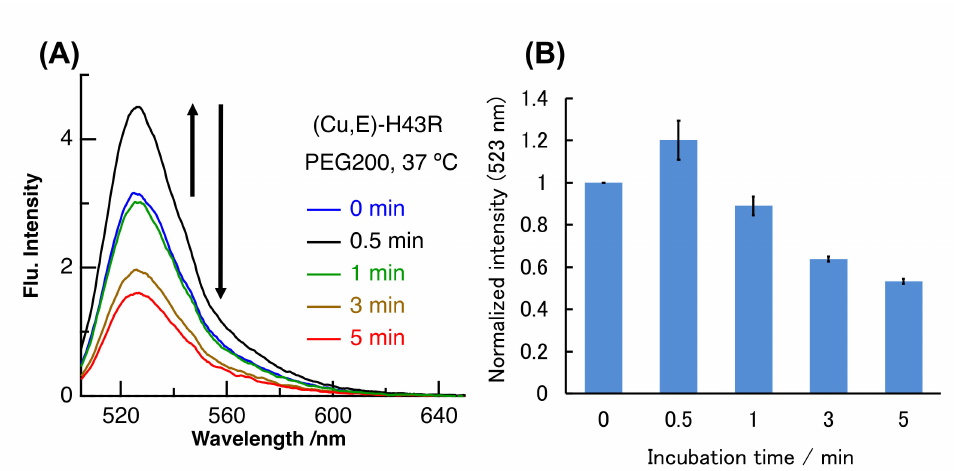
Figure 5. ( A ) Pro-oxidant activities of (Cu,E)-H43R at 37 ◦ C after di ff erent incubation times in 20 wt% PEG200 solution. ( B ) DCF intensities normalized by the value at 0 min for ( A ). Error bars are SE ( n = 3). Pro-oxidant activity was measured by the fluorescence intensity of DCF generated by the oxidation of DCFH (50 µ M) by protein (10 µ M) and H 2 O 2 (50 µ M) at room